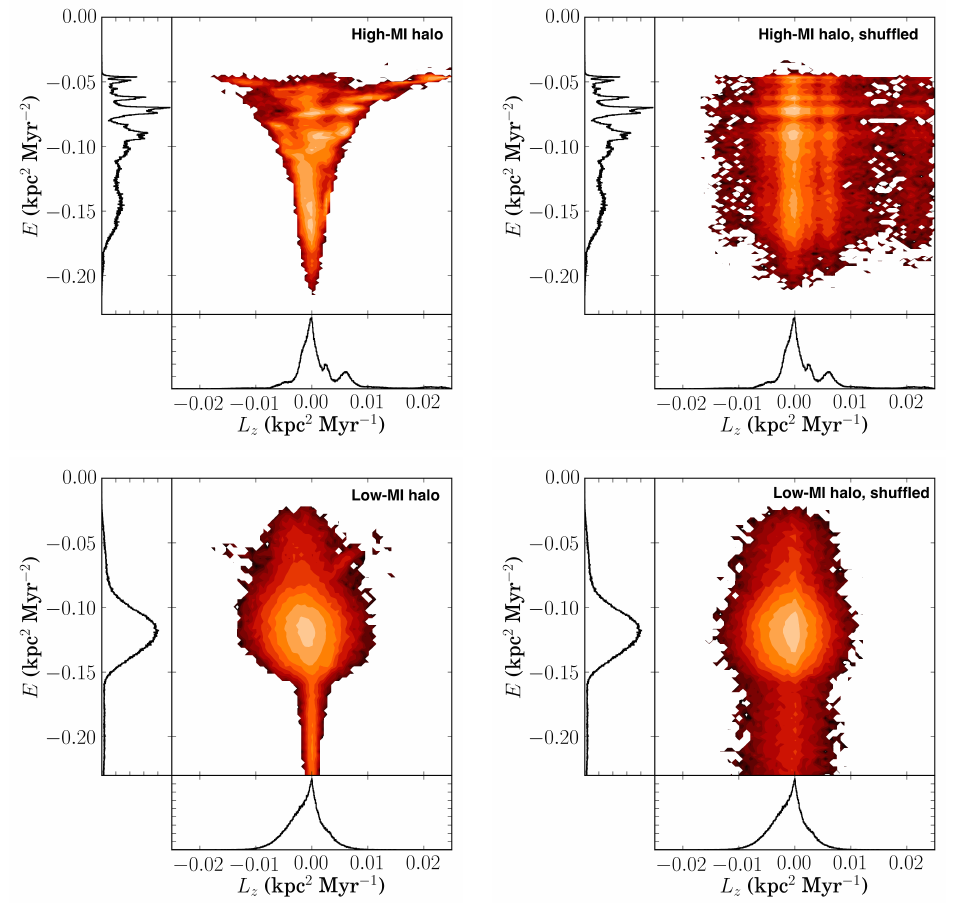
Figure 2. Measuring the degree of clustering using the mutual information. All panels show the distribution of energies and angular momenta for a region of a simulated stellar halo from one of the Latte galaxies [38]. The colors denote log projected density, with dark red denoting low density regions and light yellow regions of high density. The side-plots show the one-dimensional projected density along each dimension. The top row shows a case with a high degree of mutual information (MI, Equation (4)), where the distribution obtained by randomizing the coordinates of the stars while retaining the one-dimensional projected distributions ( right ) differs greatly from the original correlated distribution ( left ). The bottom row shows a case with a low degree of mutual information, where the distribution is similar whether or not the coordinates of the stars are shuffled. The mutual information can thus be used to measure the degree of clustering in the space of actions or constants of motion for a set of